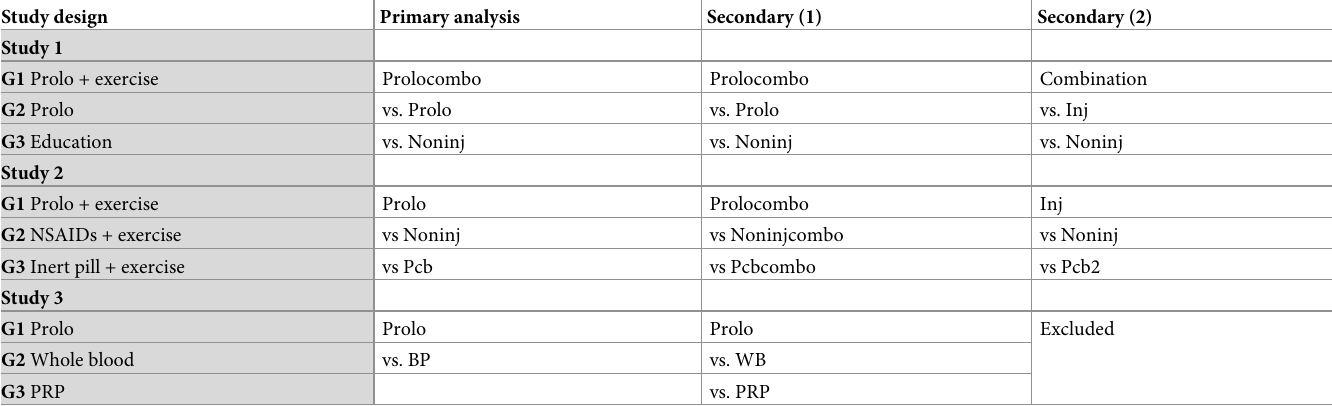
Table 1. Therapy grouping method for primary and secondary